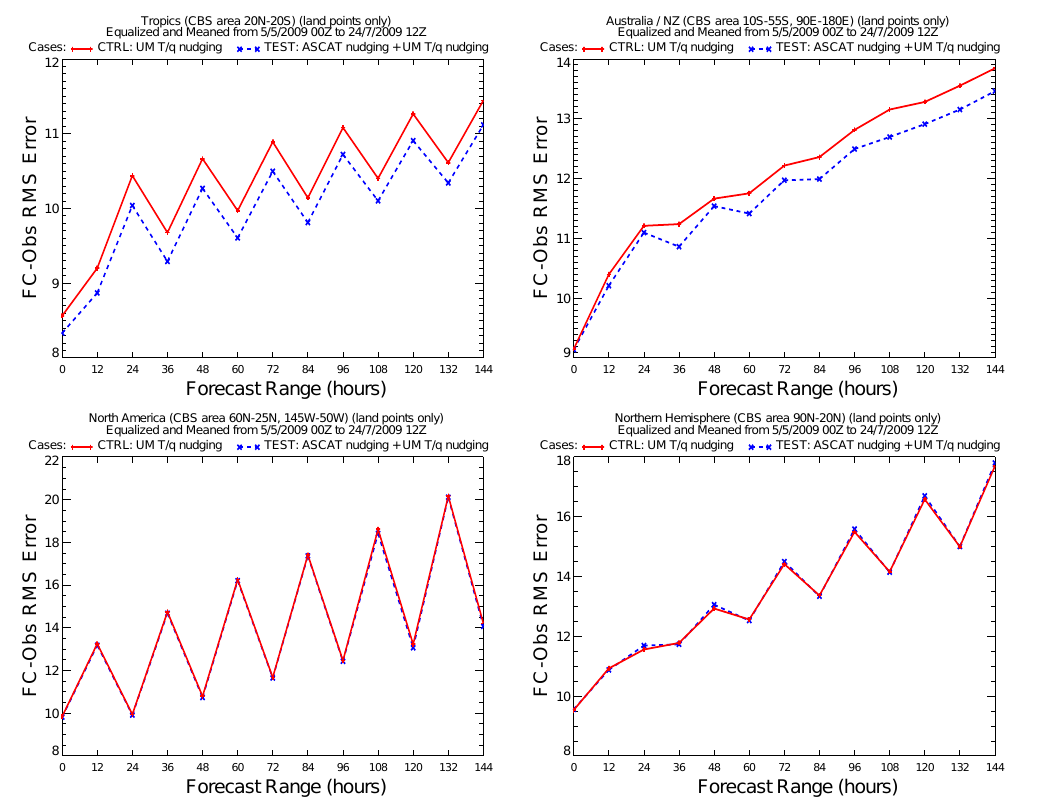
Fig. 9. Trial 1 verification of UM screen relative humidity forecasts against observations for land points only and the time period 5 May 2009 to 24 July 2009. The solid red lines (dashed blue lines) show RMS differences for the Control experiment (test experiment that also assimilates ASCAT surface soil wetness measurements). Results are shown for the tropics (20 ◦ S to 20 ◦ N), Australia (55 ◦ S to 10 ◦ S, 90 ◦ E to 180 ◦ E), North America (25 ◦ N to 60 ◦ N, 145 ◦ W to 50 ◦ W) and Northern Hemisphere regions (20 ◦ N to 90 ◦ N). 40